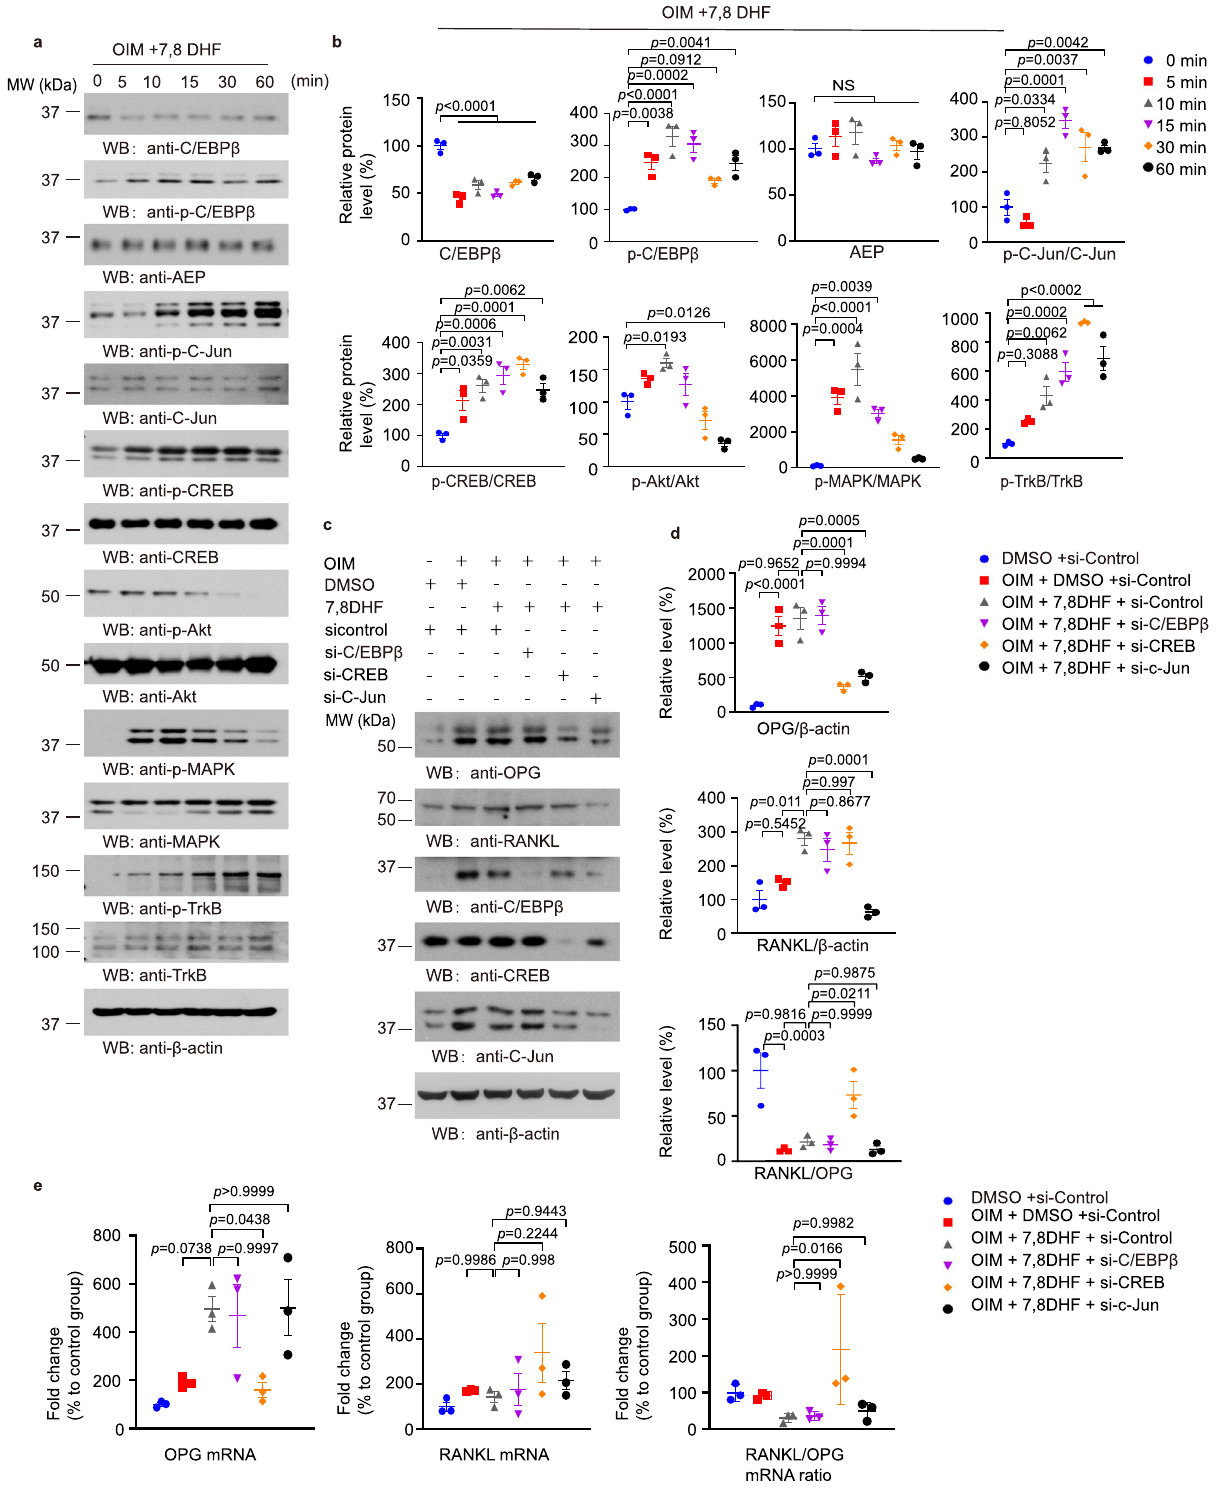
Fig. 6 | 7,8-DHF positively regulates OPG expression via activating CREB. a MC3T3 cells cultured in OIM were treated with 7,8-DHF in different time points. Western blotting showed that 7,8-DHF inhibited C/EBP β , increased Akt (S473), MAPK (p38), C-Jun, CREB phosphorylation. b Relative protein level of C/EBP β , p- C/ EBP β ,AEP,phosphorylatedC-Jun,CREB,Akt,MAPK,andTrkBinMC3T3cellstreated with 7,8-DHF in different time points. Data are shown as mean±SEM of three